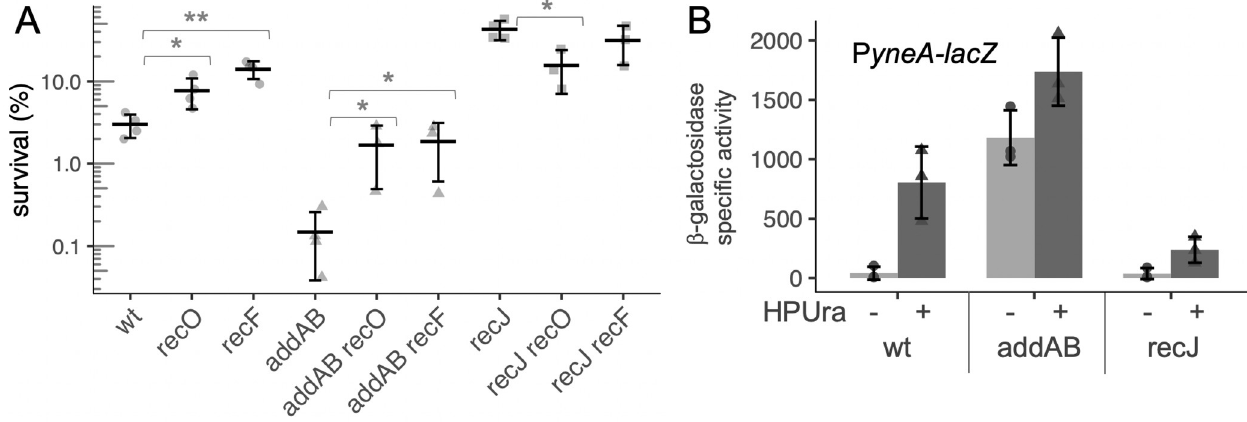
Fig 2. RecA loading is detrimental to survival during HPUra-induced replication arrest. A. Survival after HPUra treatment is greater in the absence of RecA loader and regulator (RecO, RecF). Fold change in survival after 3 h of arrest for wild type (JMA222), Δ recO (LSF814), Δ recF (LSF270), Δ addAB (LSF253), Δ addAB Δ recO (LSF817), Δ addAB Δ recF (LSF709), Δ recJ (LSF200), Δ recJ Δ recO (LSF815), Δ recJ Δ recF (LSF282). Significant difference in means (two-sample T-test): � P < 0.05; �� P < 0.01. B. RecA activity is increased in the absence of addAB and decreased in the absence of recJ . Transcription from the promoter of the SOS-inducible gene yneA is derepressed when RecA is active and serves as an indicator of RecA activity. Cultures of wild-type, Δ recJ , and Δ addAB strains containing amyE :: PyneA-lacZ (LSF633, LSF634, and LSF635, respectively) were treated or not with HPUra. After 30 min, aliquots were collected for measuring ß-galactosidase activity. Results from three independent experiments are